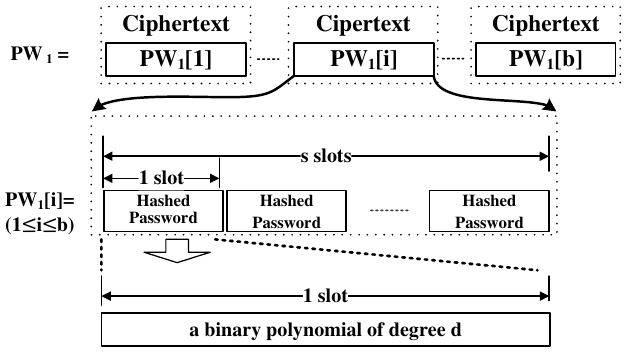
Figure 6. PW 1 encoding.